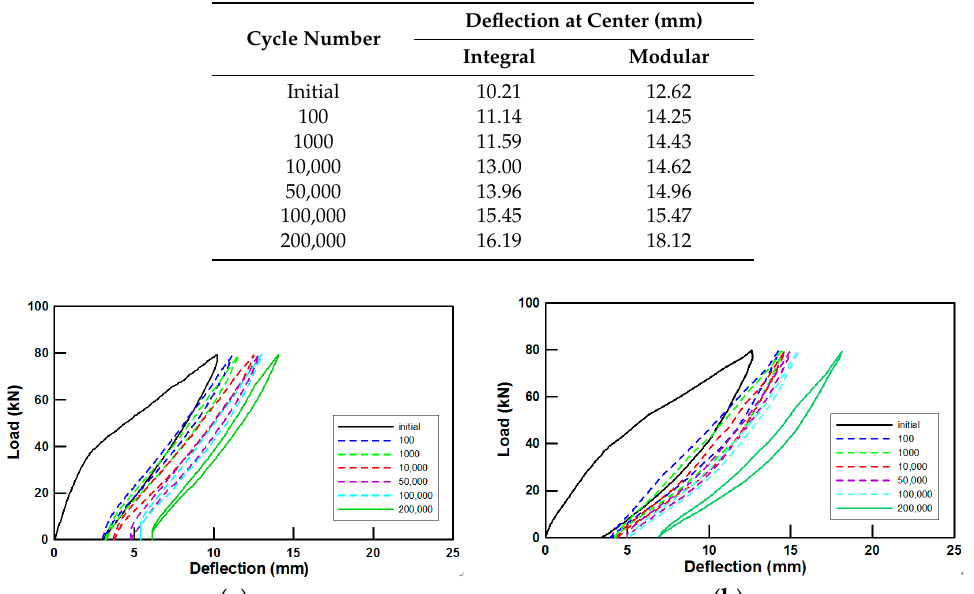
Table 1. Results of the cyclic loading test.